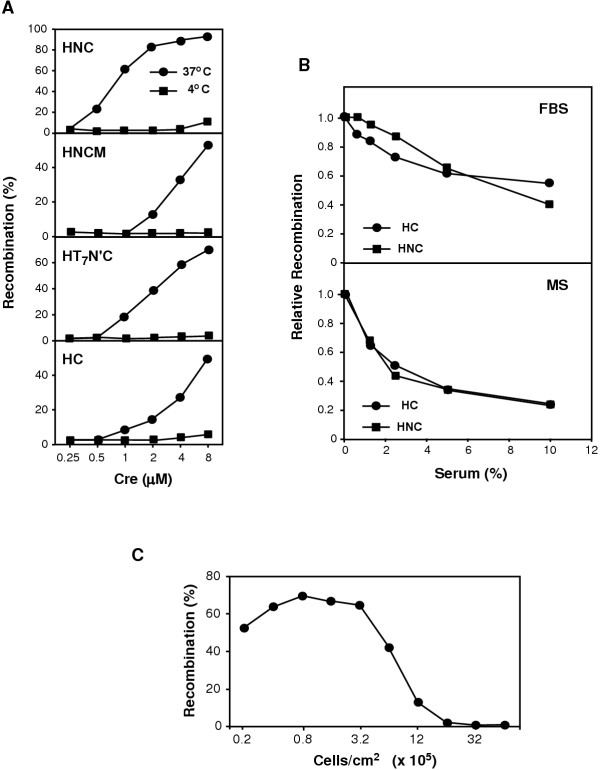
Temperature, serum and cell density effects on Cre-mediated recombination. (A) Transduction of cell-permeant Cre is inhibited at 4°C. Tex.loxp.EG cells were treated for 2 hours with increasing concentrations of the indicated enzymes at 4 or 37°C and the cells were processed and analyzed for Cre-mediated recombination as described in Figure 1. (B) Effect of serum on Cre-mediated recombination. Tex.loxp.EGFP cells were treated for 2 hours with 2 μM HNC or with 5 μM HC in the presence of increasing concentrations of fetal bovine serum (FBS) or normal mouse serum (MS) and analyzed for Cre-mediated recombination as described in Figure 1. The extent of recombination (percent GFP positive cells) was normalized to cells treated in the absence of serum. (B) Effect of cell density on Cre-mediated recombination. Increasing concentrations of Tex.loxp.EGFP cells were treated for 2 hours with 2 μM HNC and were analyzed for Cre-mediated recombination as described in Figure 1.